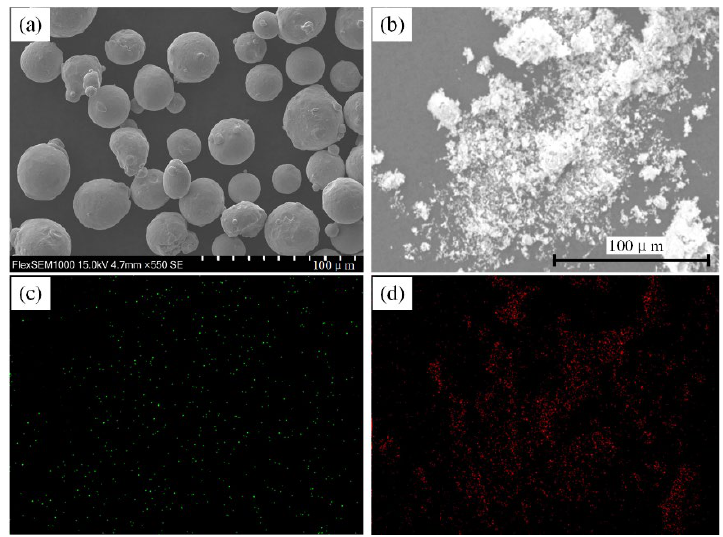
Figure 1. Microstructure of powders. ( a ) iron-chromium alloy powders, ( b ) La 2 O 3 powders, ( c ) dis- tribution of La element in La 2 O 3 powders, ( d ) distribution of O element La 2 O 3 powders.